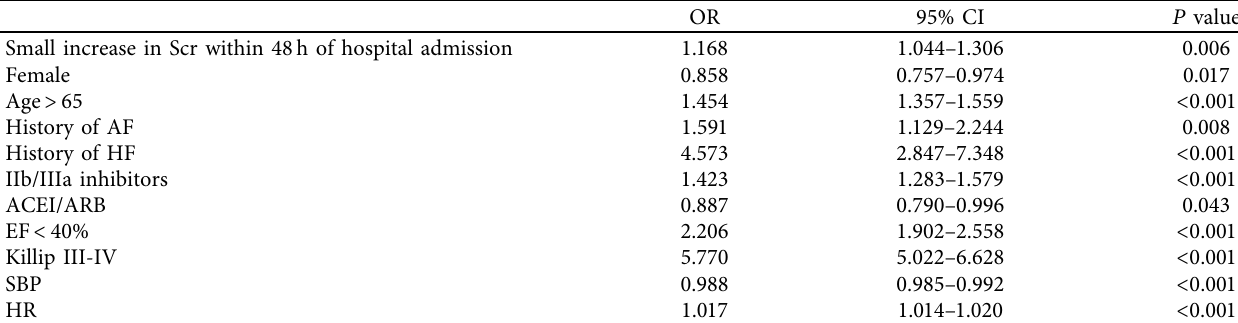
Table 3: Primary analysis: risk factors for MACE in patients with STEMI who underwent primary PCI. OR 95% CI P value